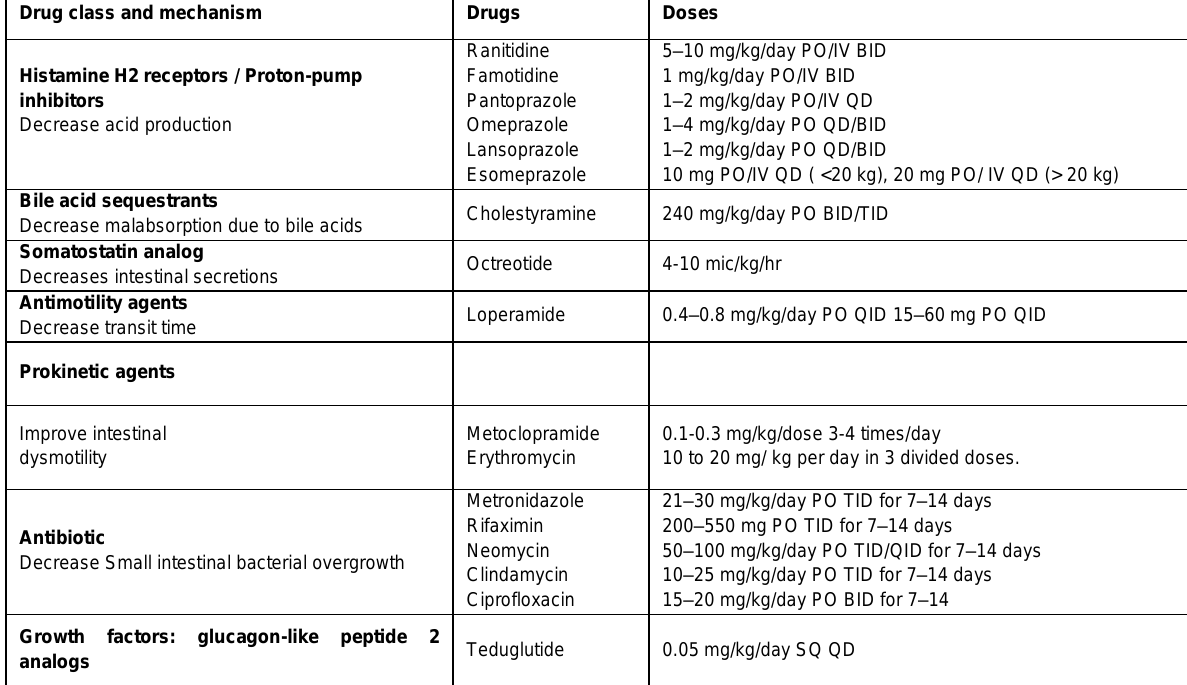
Table 2: Drugs used in the management of